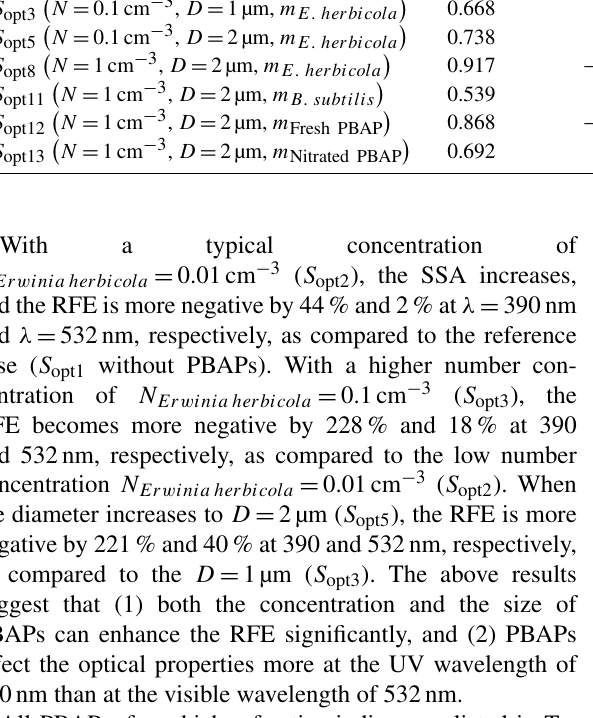
Table 3. Radiative forcing efficiency (RFE) at 390 and 532nm calculated based on Eqs. (5)–(7) (Dinar et al., 2007). Some typical conditions are shown here to demonstrate the influence of various PBAP properties such as concentration, size, and complex refractive index. Simulation SSA RFE (Wm − 2 ) (cid:49) RFE(Wm − 2 ) SSA RFE (Wm − 2 ) (cid:49) RFE(Wm − 2 ) 390nm (ultraviolet) 532nm (visible) S opt1 (without PBAPs, reference)